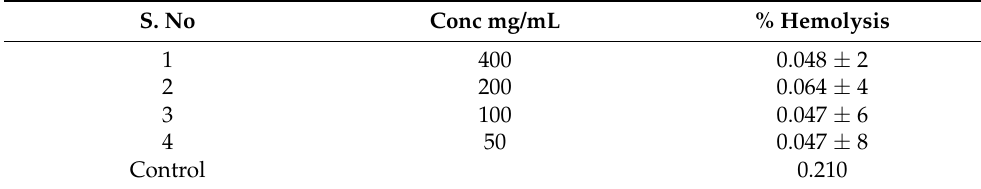
Table 4. Percent Hemolysis of the ZnO